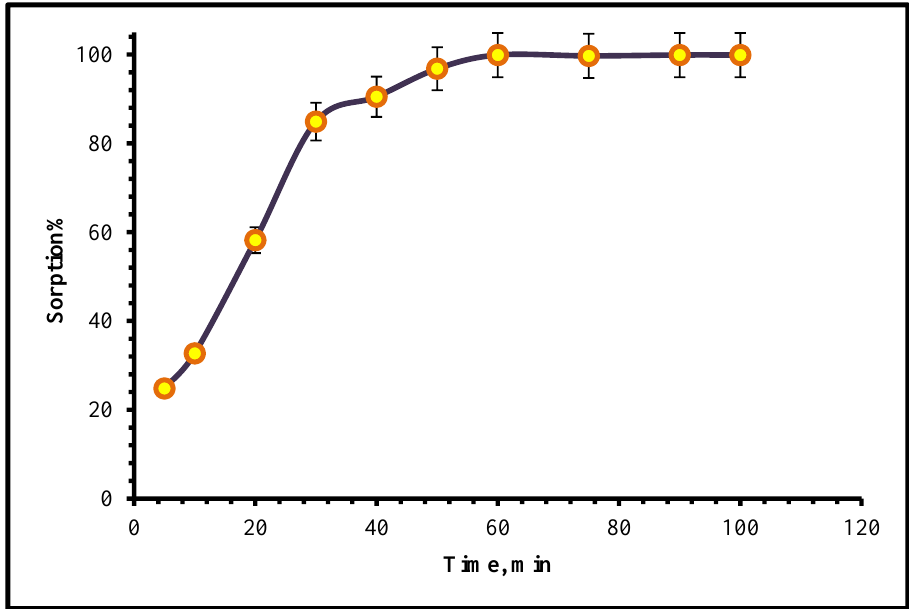
Figure 9. Effect of the agitation time on the adsorption % of W(VI) using HNAP/QA (pH 4.5, W(VI) = 250 mg L −1 , 20 mL solution, 0.08 g, room temperature).